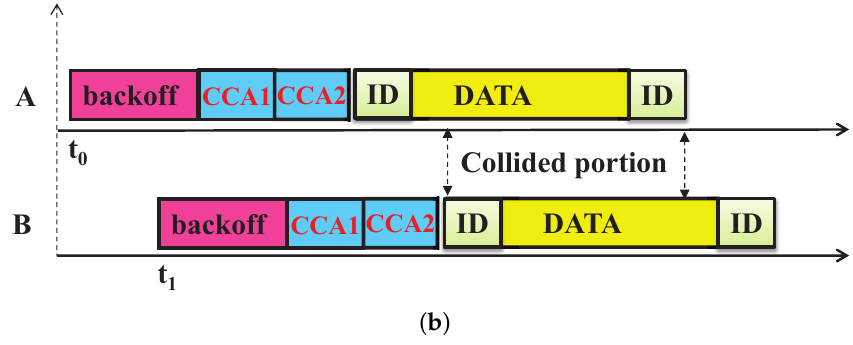
Figure 4. Address recovery during collisions due to hidden nodes. ( a ) Address of device Ais recovered correctly; ( b ) the address of both devices A and B is recovered correctly.